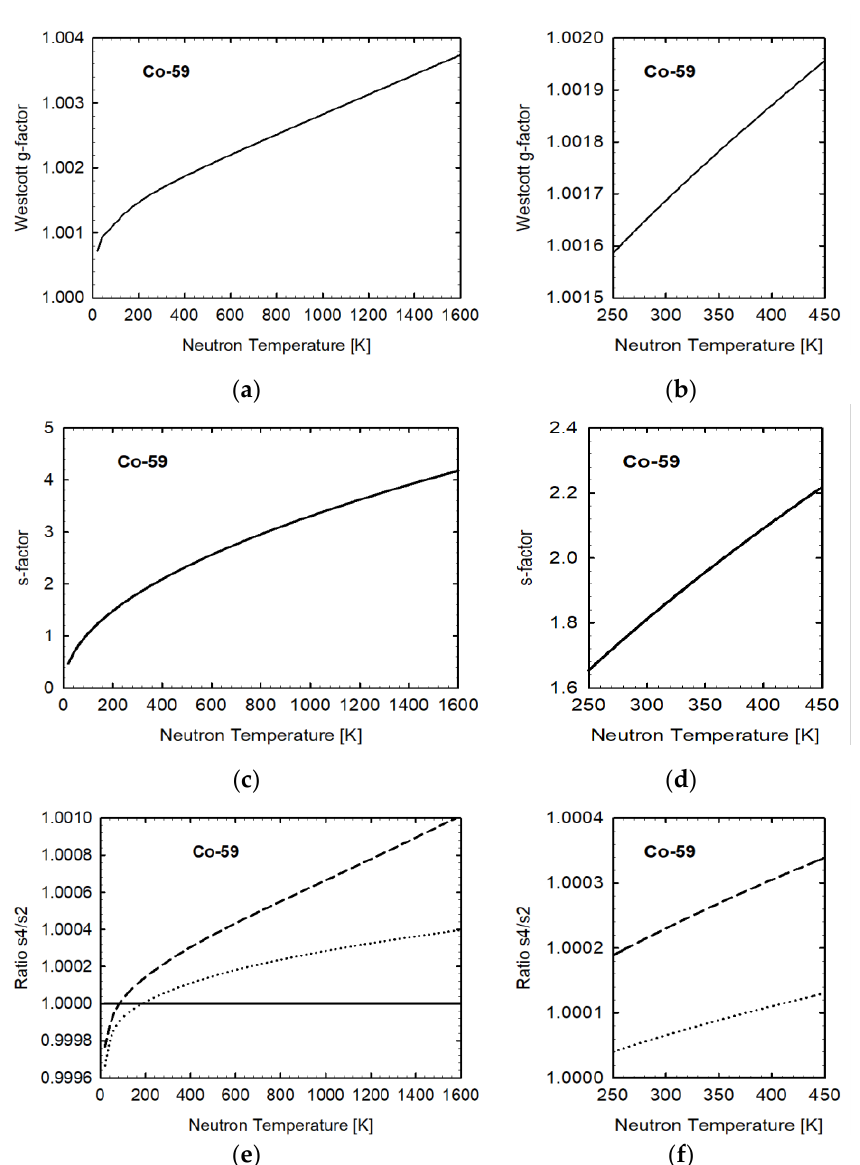
Figure 9. ( a ) Westcott g-factor for 59 Co as a function of neutron temperature 𝑇 𝑛 ; ( b ) Expanded figure of ( a ); ( c ) s-factors, s 2 𝑊 (solid line), s 4 𝑊 (dotted line), s 4 𝐻 (dashed line) for 59 Co as a function of neutron temperature 𝑇 𝑛 ; ( d ) Expanded figure of ( c ); ( e ) Ratios of s-factors, s 4𝑊 /s 2𝑊 (dotted line) and s 4H /s 2𝑊 (dashed line) for 59 Co; ( f ) Expanded figure of ( e ).